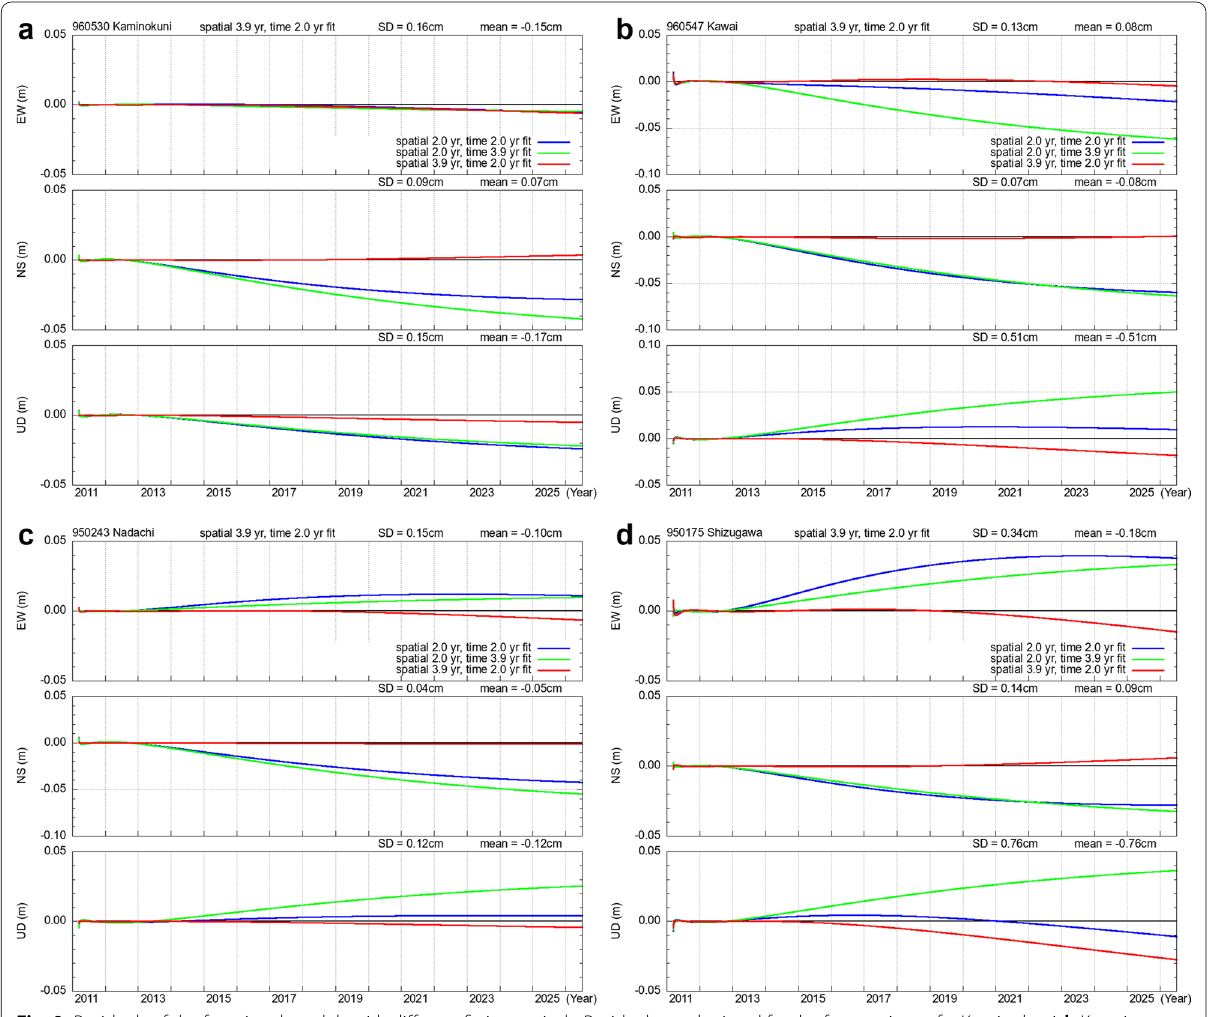
Fig. 9 Residuals of the functional models with different fitting periods. Residuals are depicted for the four stations of a Kaminokuni, b Kawai, c Nadachi, and d Shizugawa (Fig. 1). Residuals of the three components of east–west (EW), north–south (NS), and up–down (UD) are drawn for each station from the day after the 2011 Tohoku-Oki earthquake to 2026.5. As a reference value, we use the 3.9-year model (the spatial functions with the fitting period of 3.9 years and the time constants of the 3.9-year model [S3.9T3.9]). Blue lines represent the residuals of the time series for the spatial functions with the fitting period of 2.0 years and the time constants of the 2.0-year model [S2.0T2.0]. Green lines represent the residuals of the time series for the spatial functions with the fitting period of 2.0 years and the time constants of the 3.9-year model [S2.0T3.9]. Red lines represent the residuals of the time series for the spatial functions with the fitting period of 3.9 years and the time constants of the 2.0-year model